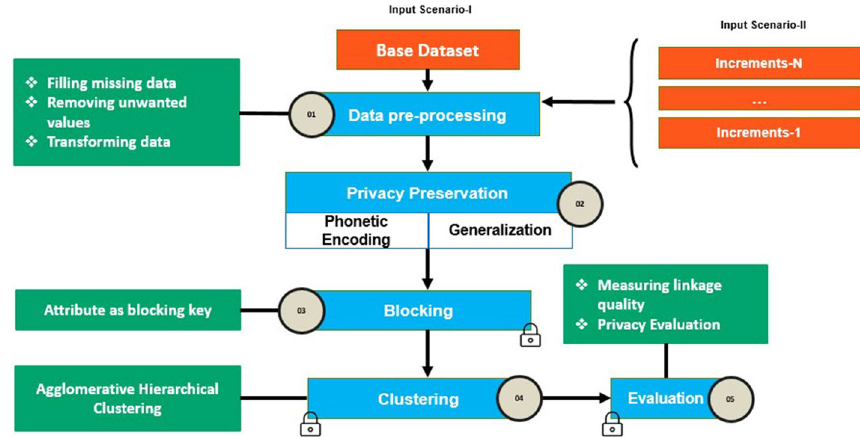
Fig. 9 Impact of incremental feature on the PPiRL